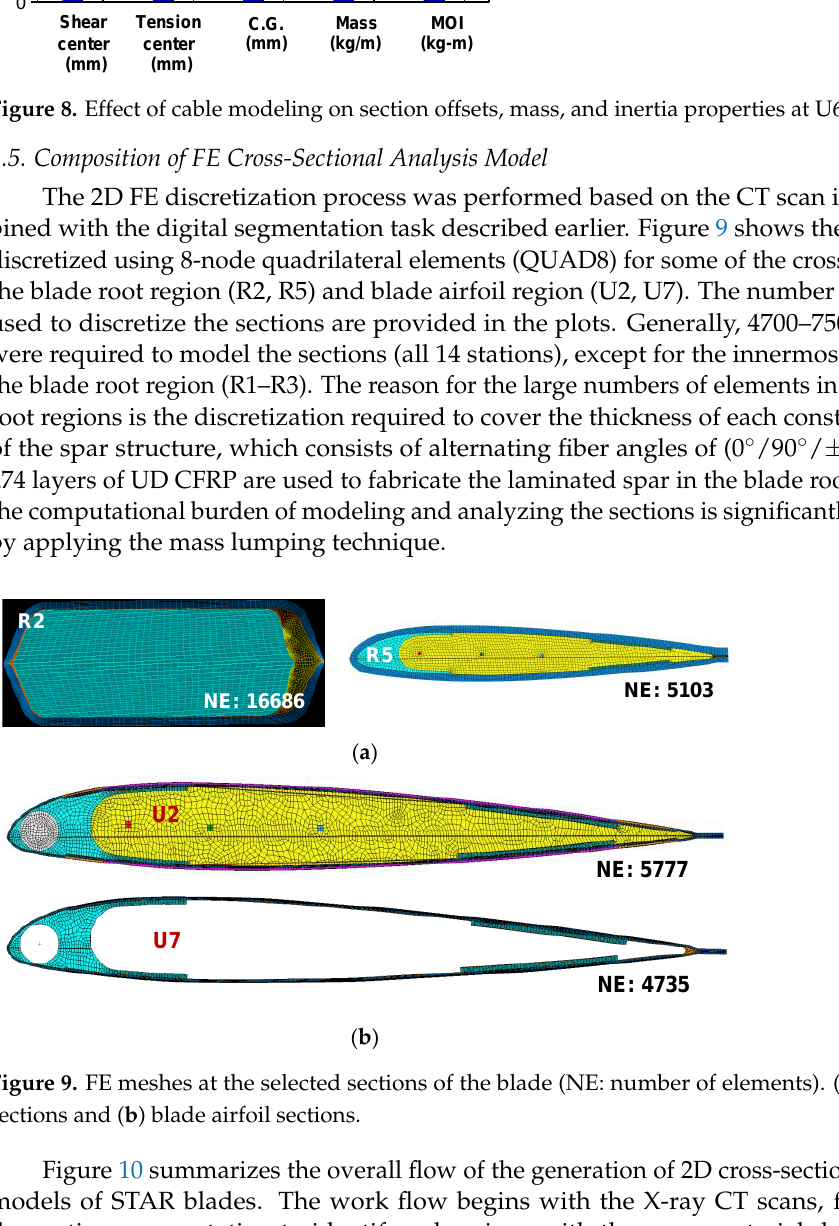
Figure 8. Effect of cable modeling on section offsets, mass, and inertia properties at U6.